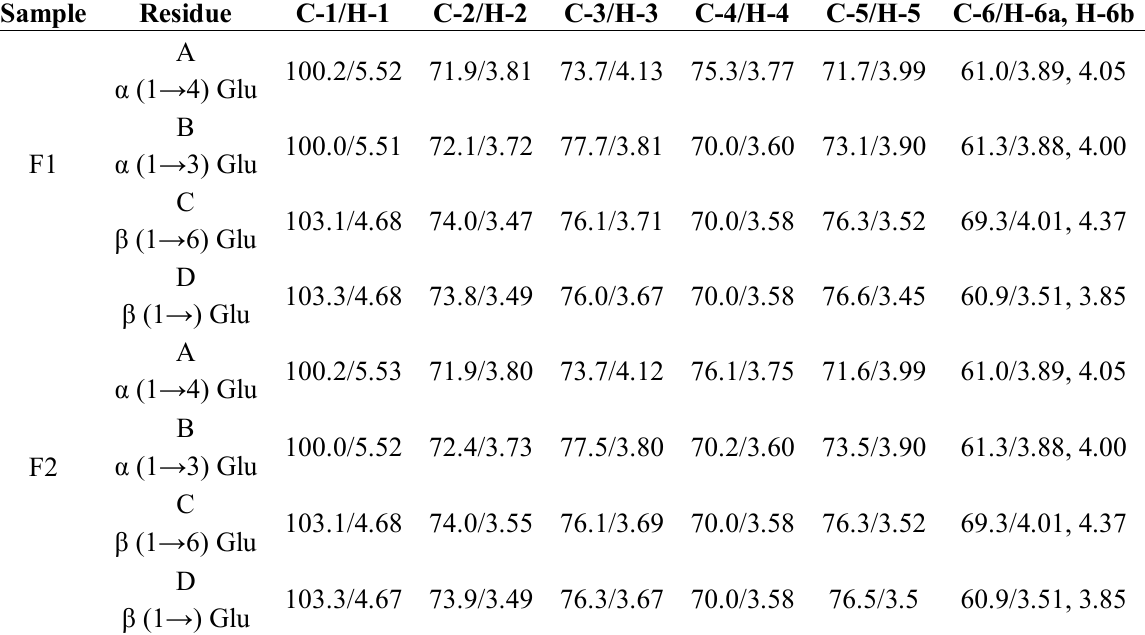
Table 3. 1 H- and 13 C-NMR spectral data of F1 and F2 in D (relative to external TSP, =0 ppm) for F1 and F2 in aqueous solution.